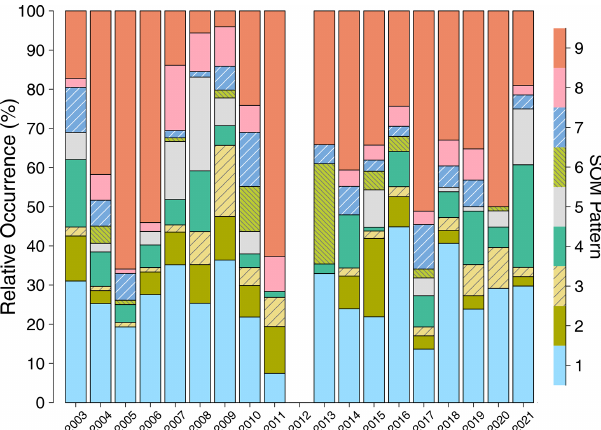
Figure 5. Relative occurrence of the nine melt patterns each sum- mer. A value of 20% on the y axis indicates that 20% of the days in a given melt season were best described by the given pattern. Years on the x axis refer to the January date of the summer (e.g. 2016 is 2015/16). No AMSR sensor operated in 2011/12. See also Fig.